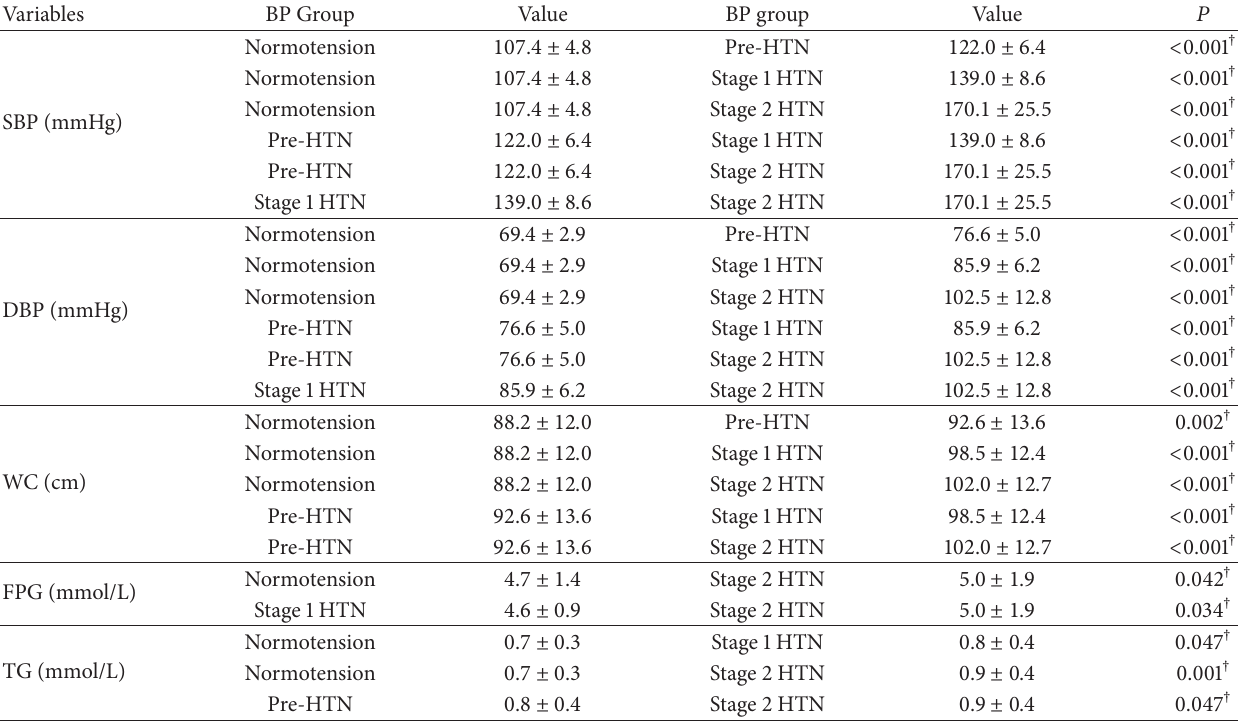
Table 2: Comparison of components of MS among BP